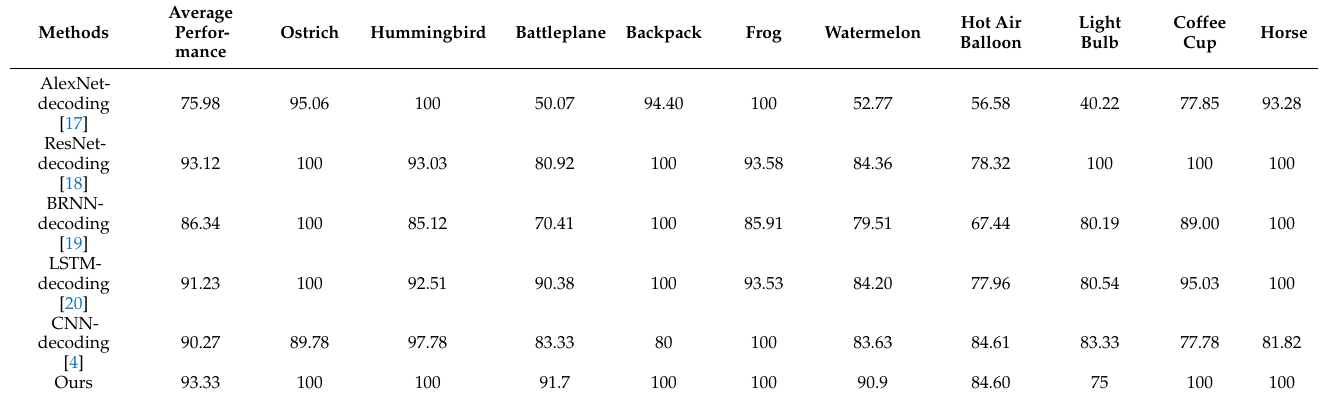
Table 5. Comparison of experimental results (recall, %).